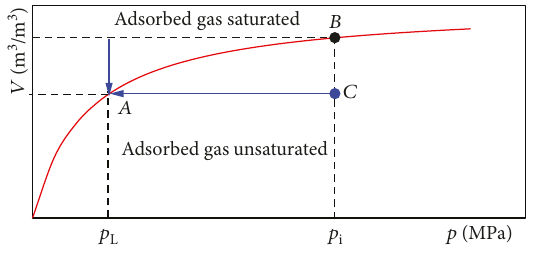
Figure 2: Shale gas isothermal adsorption curve and desorption process diagram.